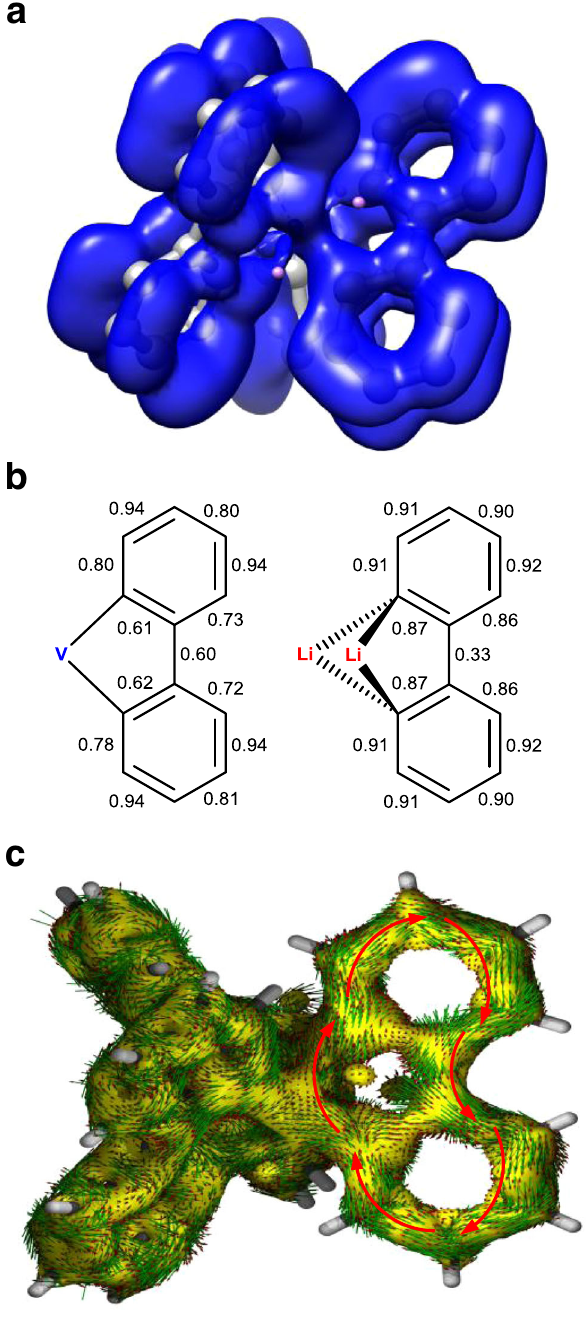
Fig. 4 Analyses on the aromaticity of complex 2. a The ELF- π isosurface of 2 at 0.35. b ELF- π bifurcation values of the biphenyl ligands in 2 (Ring A) and 1 . c AICD plot of 2 from π contribution. AICD isosurface of 0.03 is shown in yellow. Red arrows represent the direction of the ring current. The magnetic fi eld vector is orthogonal to the ring plane and points outside (clockwise currents are